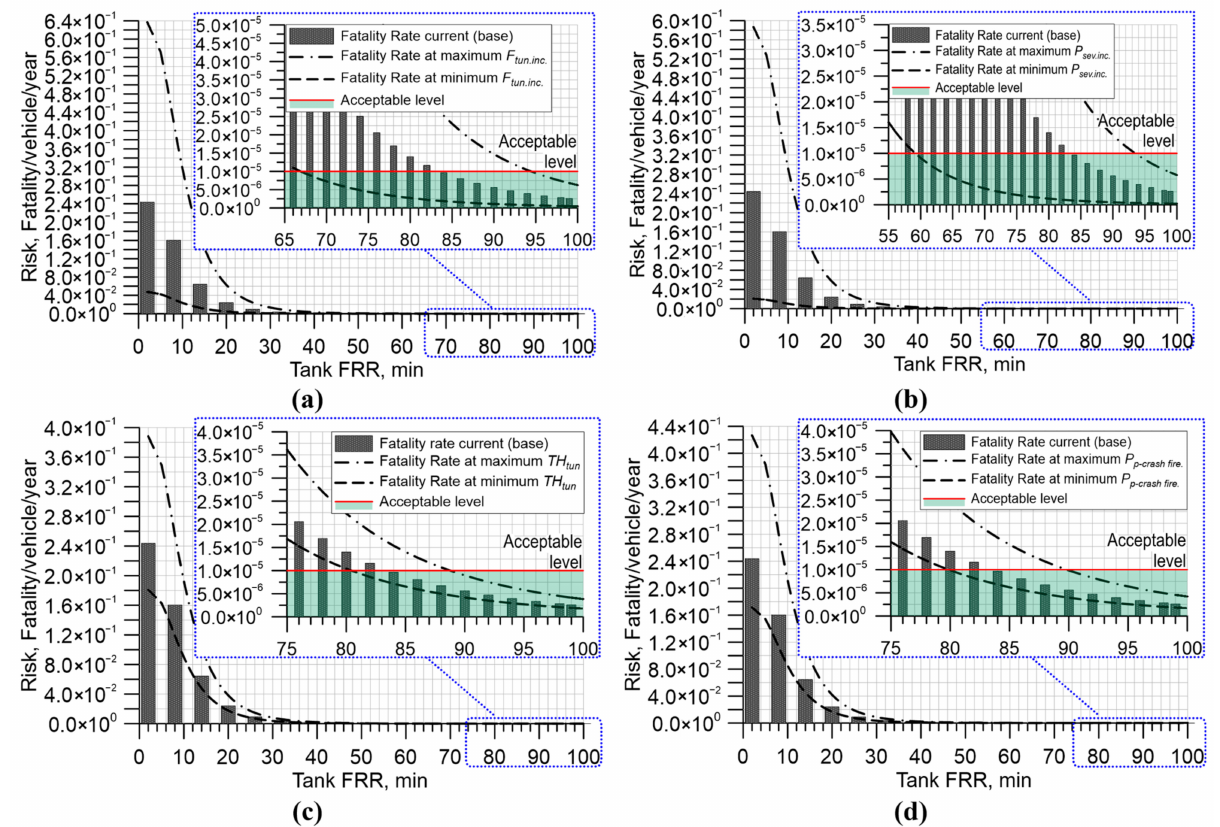
Figure 8. Sensitivity analysis of different parameters on the risk of hydrogen tank rupture in road tun- nel: ( a )—tunnel incident frequency; ( b )—the probability of occurrence of severe incident; ( c )—annual throughput for Dublin tunnel; ( d )—the probability of post-crash